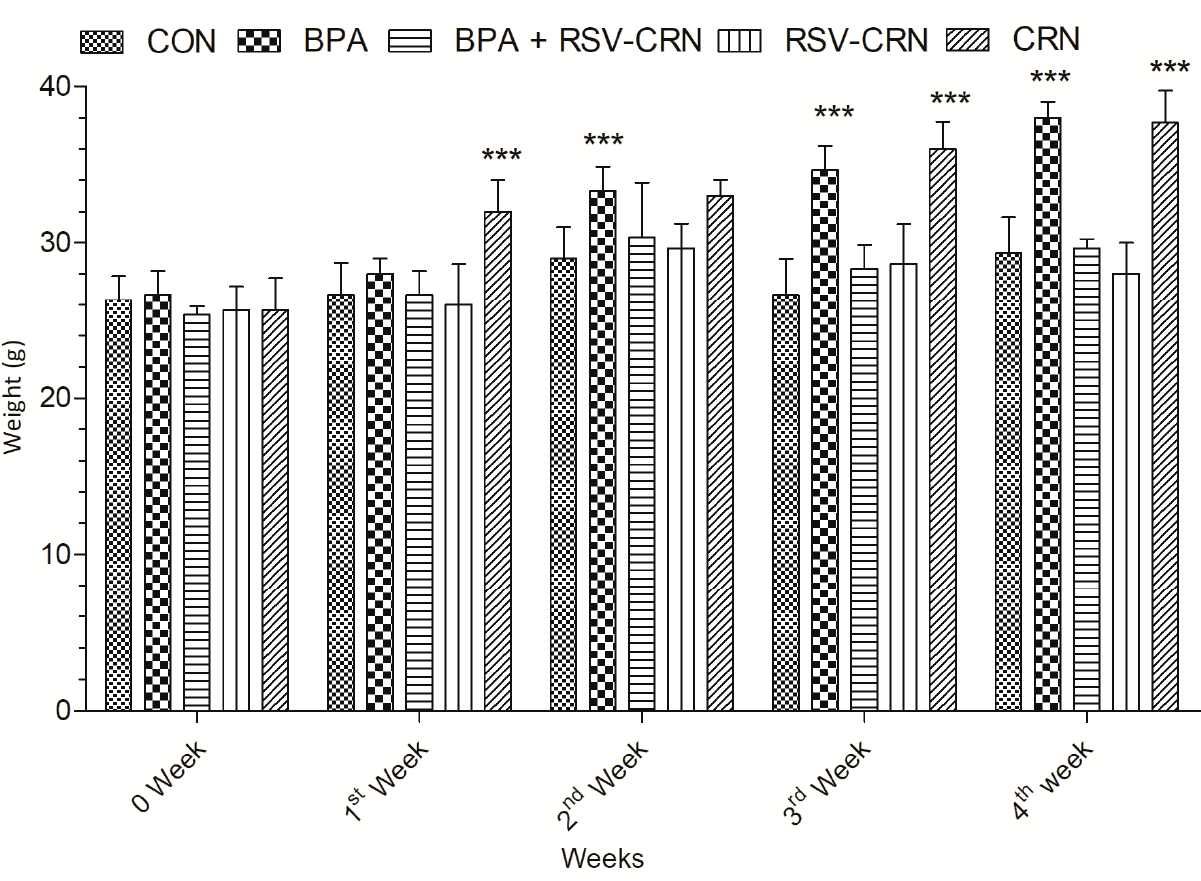
Figure 2. A graphical representation of weight gain in all groups over the experiment timeline. Week 0 represents the weight of the animals at the start of the study. Here, it can be seen in the 1st week bar charts that only the corn oil receiving group showed a significant increase in weight, which can be observed throughout the study. The BPA receiving group showed significant p < 0.05 weight gain in the 2nd week of the study as compared to week 0. This increase in weight of the BPA receiving group was also observed in the 3rd and 4th week of the study. At the end of the study, both the BPA receiving and corn oil receiving group showed significant p < 0.05 weight gain as compared to the start of the study and the control group. In the resveratrol receiving groups, i.e., BPA+RSV-CRN and RSV+CRN, the role of resveratrol in combating weight gain can be observed throughout the experiment timeline. Both groups showed restraint in weight gain as compared to the BPA and CRN group and showed a non-significant difference to the start of the study and among each other. The results were analyzed using a two-way ANOVA followed by Bonferroni’s post-test comparison. Here *** shows a highly significant difference, i.e., weight gain in the groups receiving corn oil and the group receiving BPA throughout the study as compared to week 0. Each group contained 5 animals.